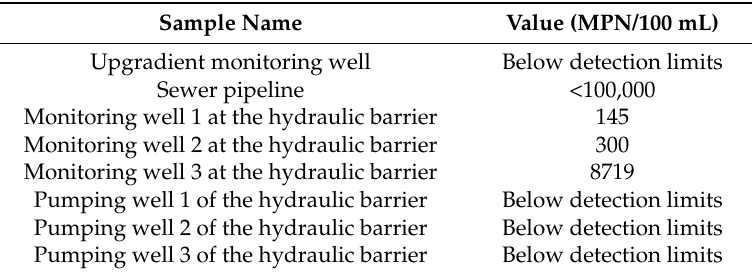
Table 2. Total coliforms detection via Most Probable Number analysis, from Sbarbati et al. [19]. Monitoring wells and pumping wells locations are showed in Figure 1 (except the upgradient monitoring